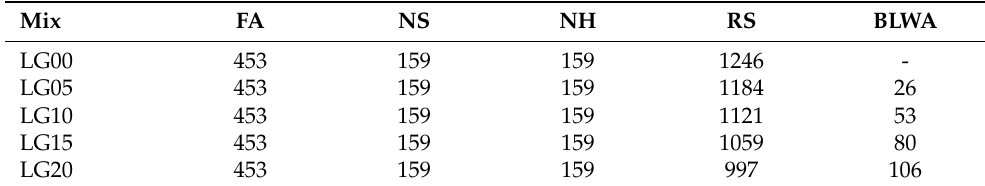
Table 4. Mix proportion of geopolymer mortar (kg/m 3 ).